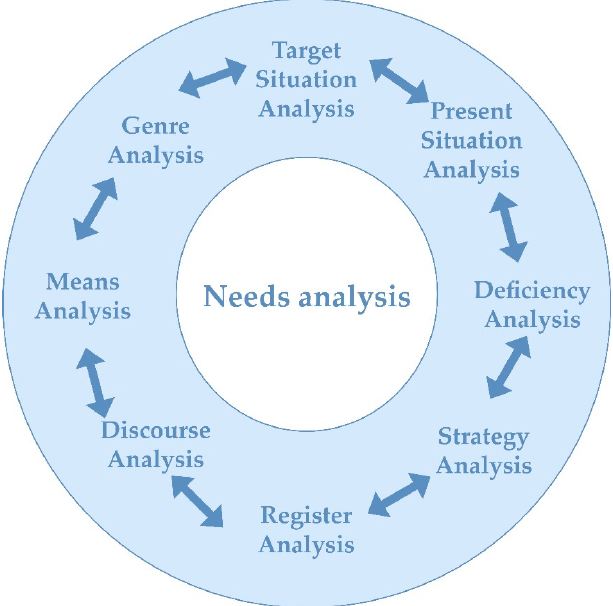
Figure 1. Approaches to needs